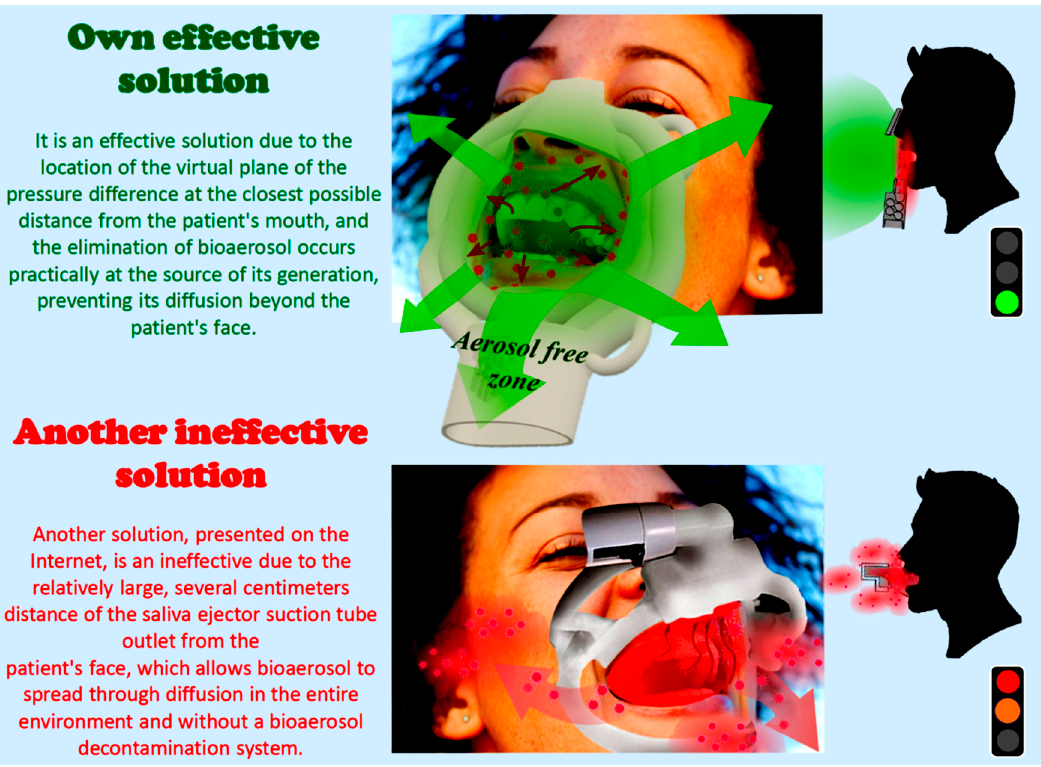
Figure 12. Comparison of the effectiveness of SARS-CoV-2 virus capture by a proprietary face cap and a solution available on the Internet.